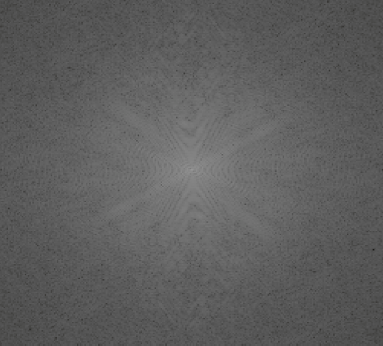
Figure 7: Grayscale PSD visualization.